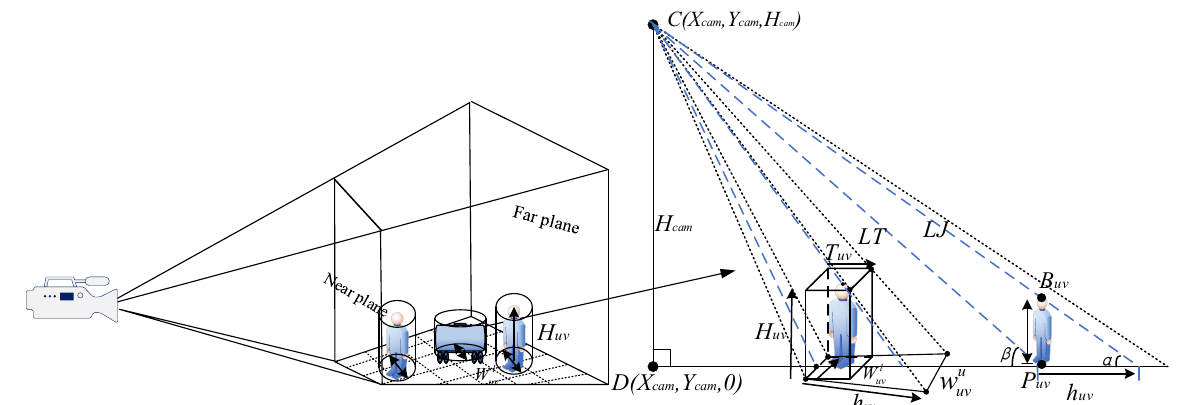
Figure 2. Illustration of object projection.